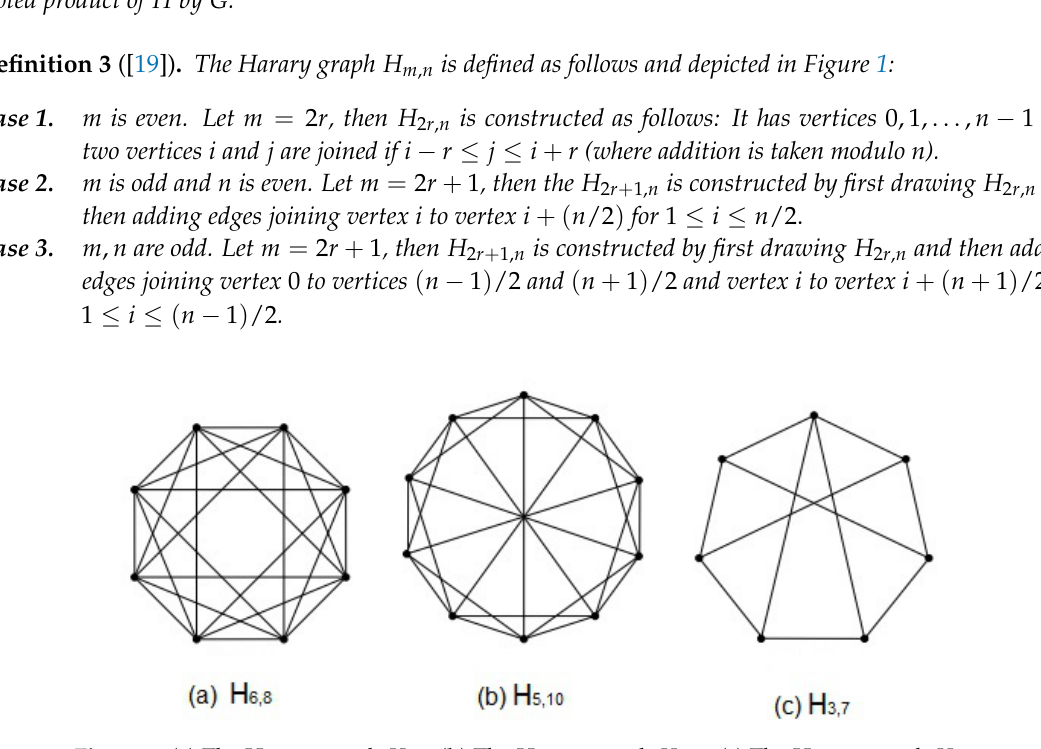
Figure 1. ( a ) The Harary graph H 6,8 ; ( b ) The Harary graph H 5,10 ; ( c ) The Harary graph H 3,7